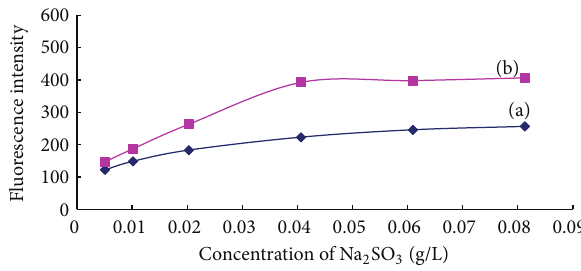
Figure 8: Effect of Na 2 SO 3 concentration on the fluorescence intensities of blank (a) and 0.200 𝜇 mol/L ammonium working solution (b).